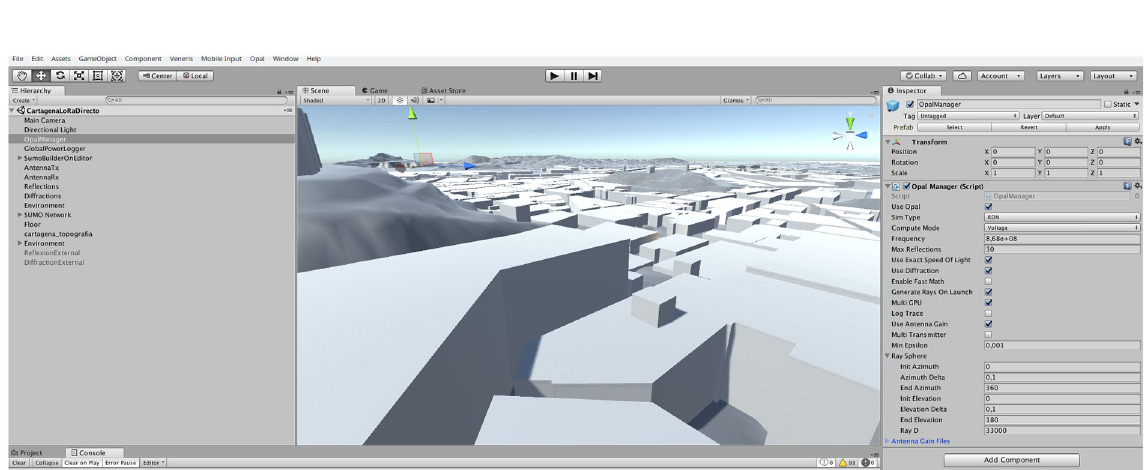
Fig 5. Cartagena scenario. To increase the simulation accuracy the Cartagena city scenario has been enhanced with terrain elevation data and high accuracy building data from public spatial information sources. Snapshot taken from the Opal tool.